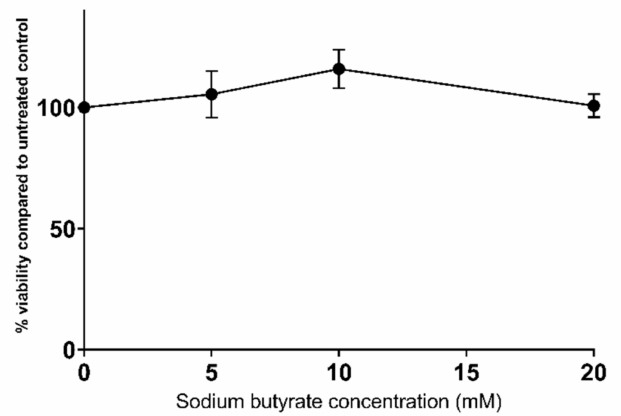
Figure 1. Sodium butyrate is not toxic to HepG2 cells when used at millimolar concentrations. Cells were exposed to butyrate for 24 h and viability assessed using the AlamarBlue ® assay. Results represent the mean from at least three independent experiments ±